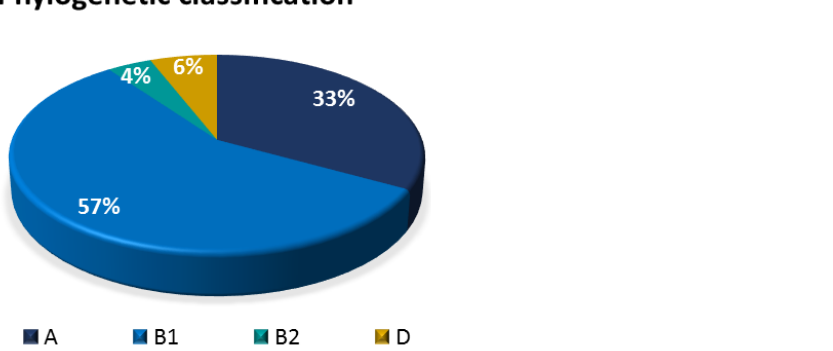
Figure 11. Pie chart showing the relative distribution of phylogenetic groups among bovine fecal E. coli isolates.